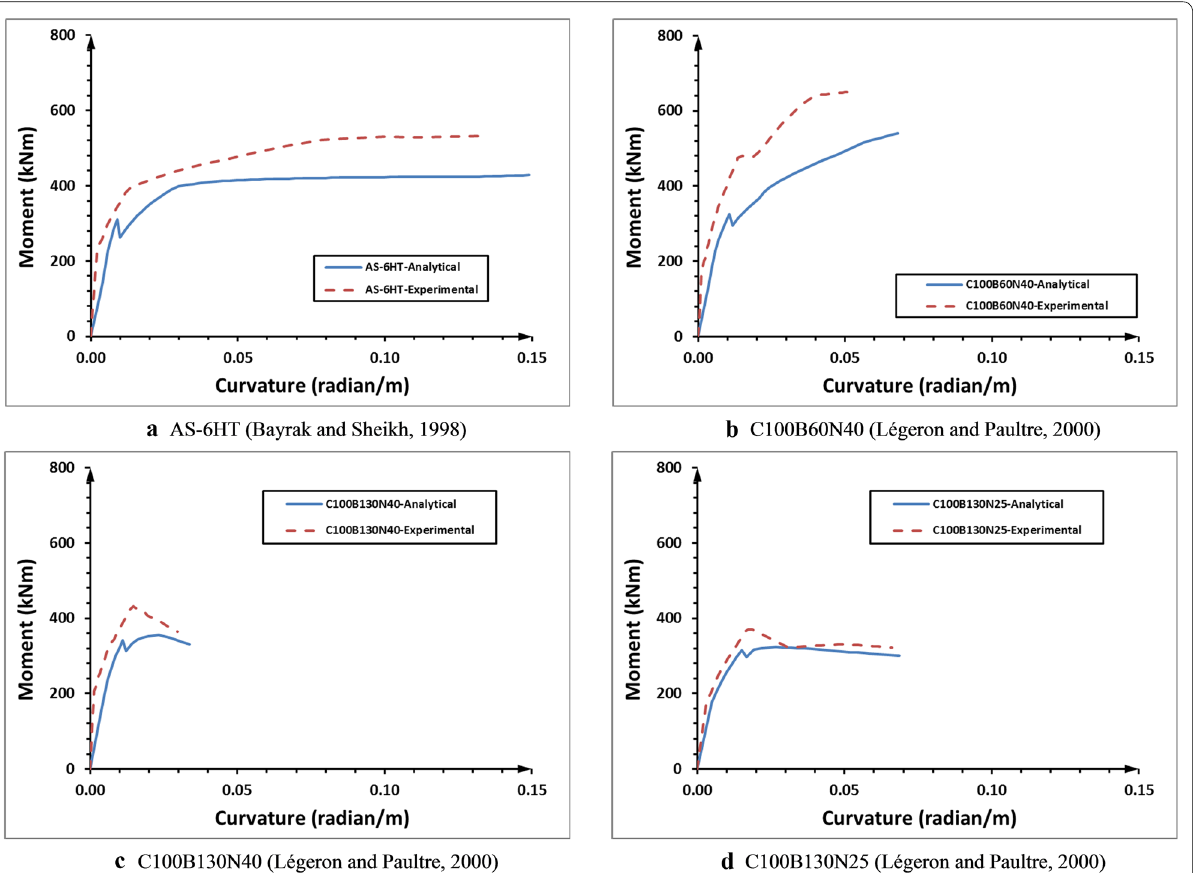
Fig. 7 Analytical versus experimental moment–curvature behavior.